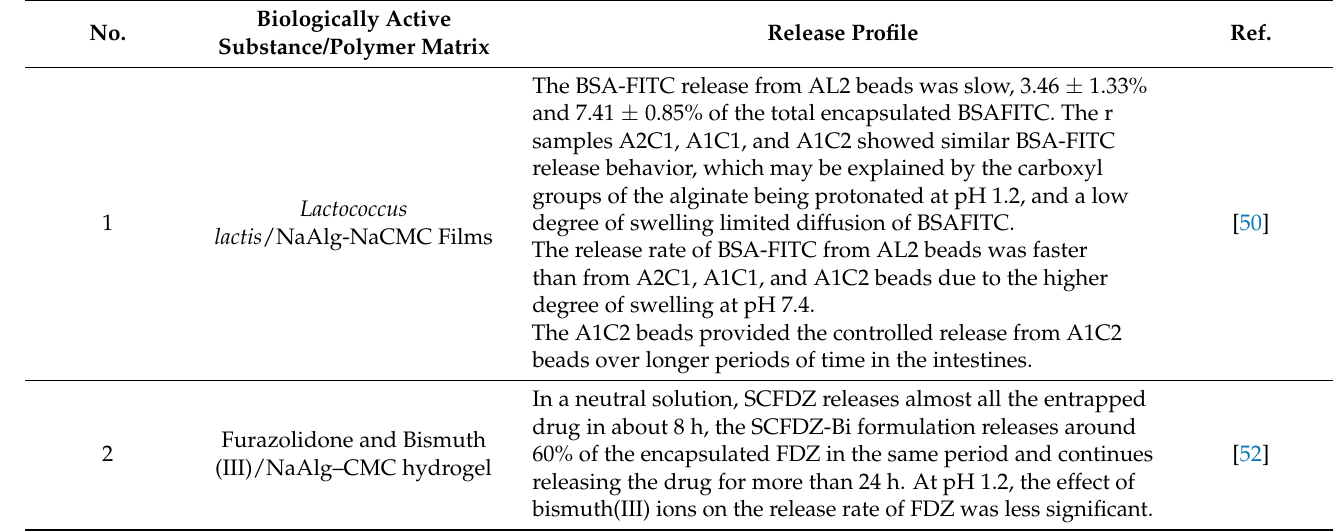
Table 1. Release profile of a biologically active substance from polymer